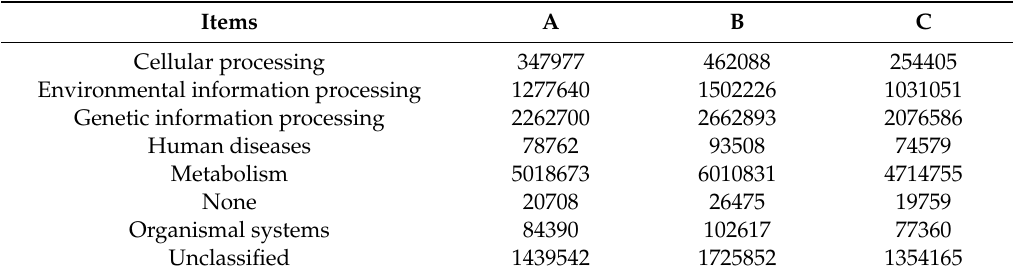
Table 5. Prediction for KEGG pathways of bacterial communities